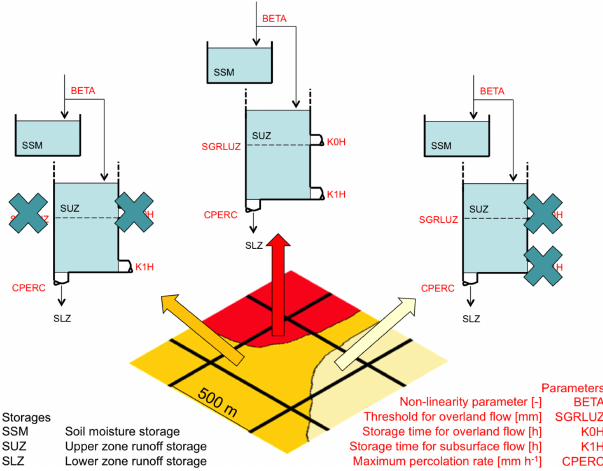
Figure 4. Schematic representation of the spatial discretisation and structure of RGM-PRO. For each class of a given process map, a specific storage system can be defined. For list of abbreviations see Appendix A. Similar distributed model structures can be found, for example, in Gharari et al. (2014), Fenicia et al. (2016), Nijzink et al.